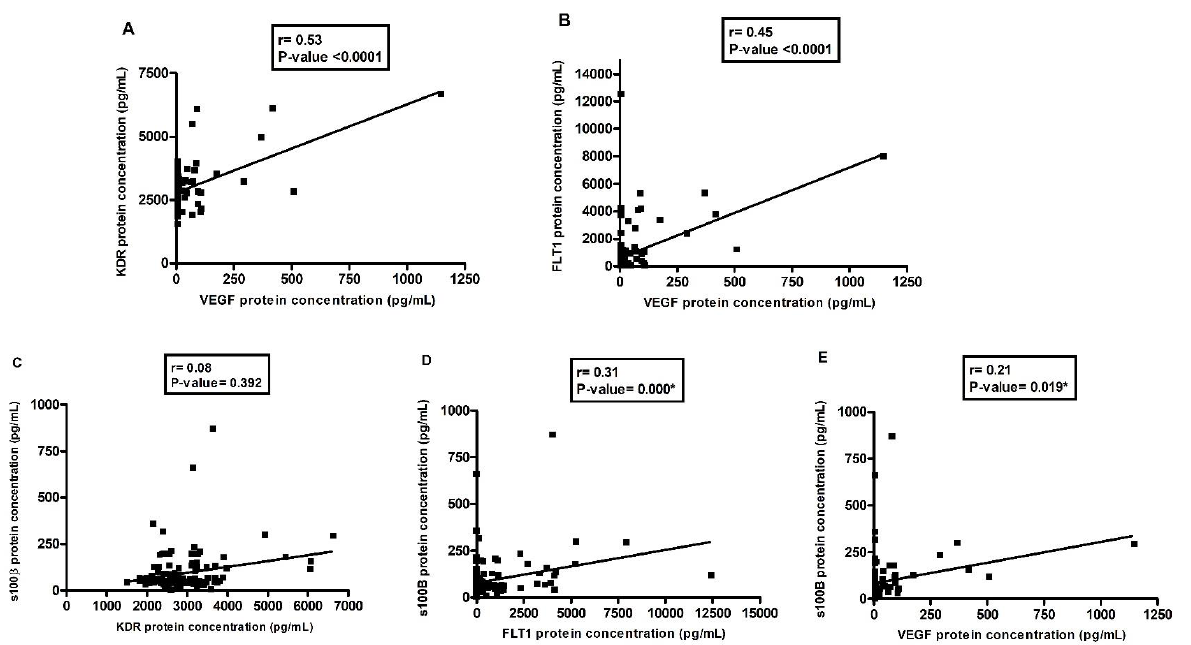
Figure 2. Correlation graph between plasma concentrations of VEGF with its inhibitors and VEGF with s100 β protein in depressive group. Legend: Spearman’s test was used for non-parametric analysis and Pearson’s test was used for parametric analysis. * p < 0.05 was considered statistically significant. ( A ) correlation analysis between KDR and VEGF; ( B ) correlation analysis between FLT1 and VEGF; ( C ) correlation analysis between s100 β and KDR; ( D ) correlation analysis between s100 β and FLT1; ( E ) correlation analysis between s100 β and VEGF.